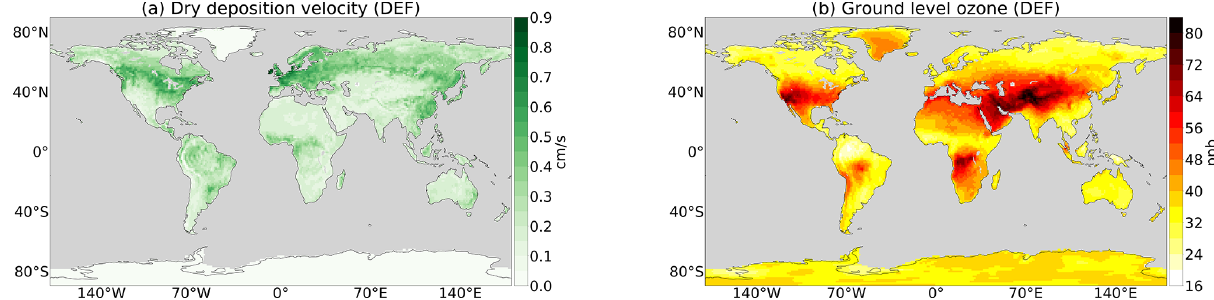
Figure 6. Multiyear (2010–2015) mean absolute values in boreal summer.